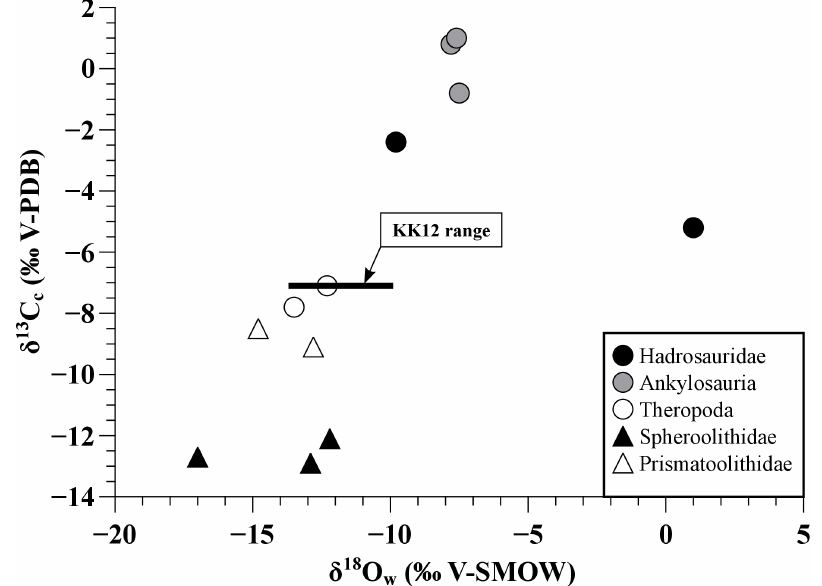
Figure 3. Oxygen isotope compositions of local water ( δ 18 O w ) estimated from the δ 18 O c values of dinosaur eggshells (triangles) and tooth apatite phosphate (circles), reported against the carbon isotope compositions of eggshell calcite or tooth apatite carbonate ( δ 13 C c ). The black horizontal bar corresponds to the range of water δ 18 O w values estimated from the intra-tooth δ 18 O p value variation measured on the tyrannosaurid tooth KK12